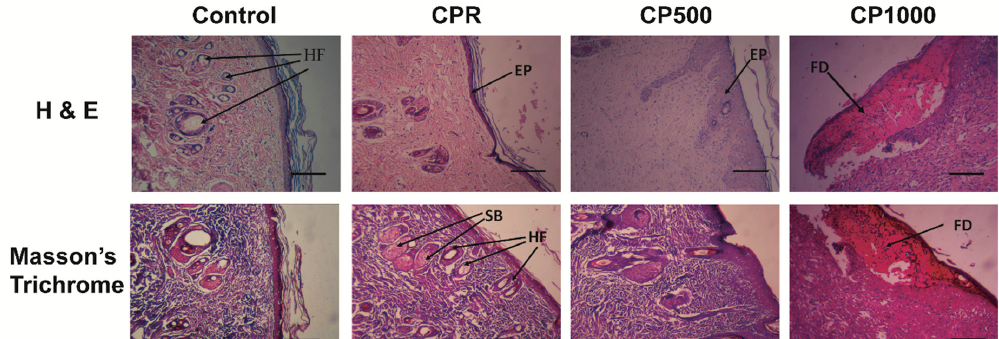
Figure 4. Hematoxylin and eosin and Masson’s trichrome staining in different groups on day 14. FD, fibrinous debris; EP, epithelialization; HF, hair follicle; SB, sebaceous gland. (Scale bar = 50 µm.).